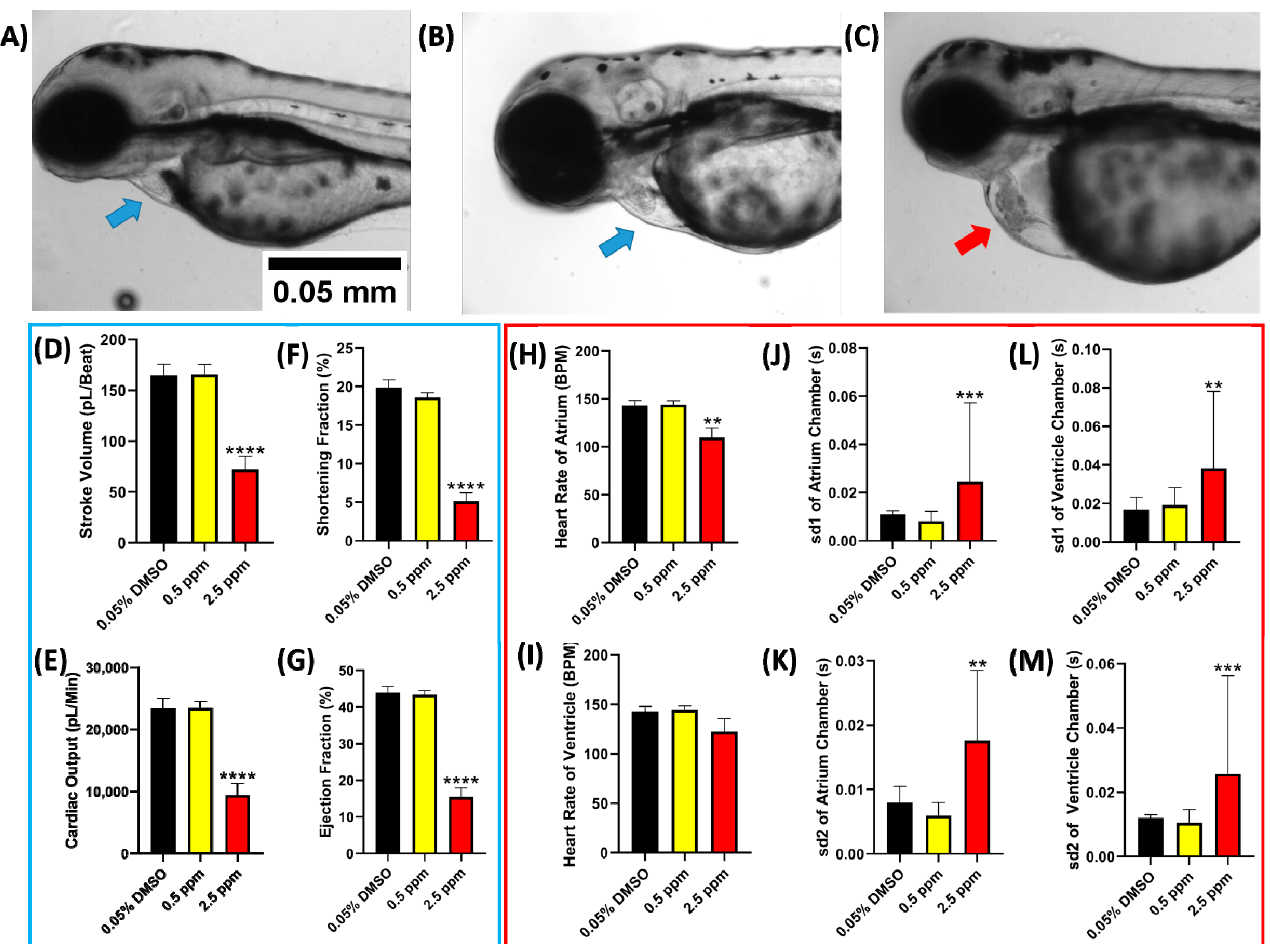
Figure 2. The morphology of 72 hpf zebrafish larvae after acute exposure in 0 ( A ), 0.5 ( B ), and 2.5 ppm ( C ) of PON (blue arrow show normally developed cardiac chamber while red arrow show abnormal development of cardiac chamber). Zebrafish cardiac physiology parameters ( D – G , blue box) and cardiac rhythm parameters (( H – M ), red box) after exposure to PON. Data are presented as mean ± standard deviation, and the statistical significance was calculated using ordinary one-way ANOVA with Dunnet multiple comparison test. (** p < 0.01, *** p < 0.001, **** p < 0.0001). Contrary to the PON, acute exposure in ASC did not significantly alter the cardiac performance in zebrafish (Figure 3D–M) even after incubation at 10 ppm. No heart